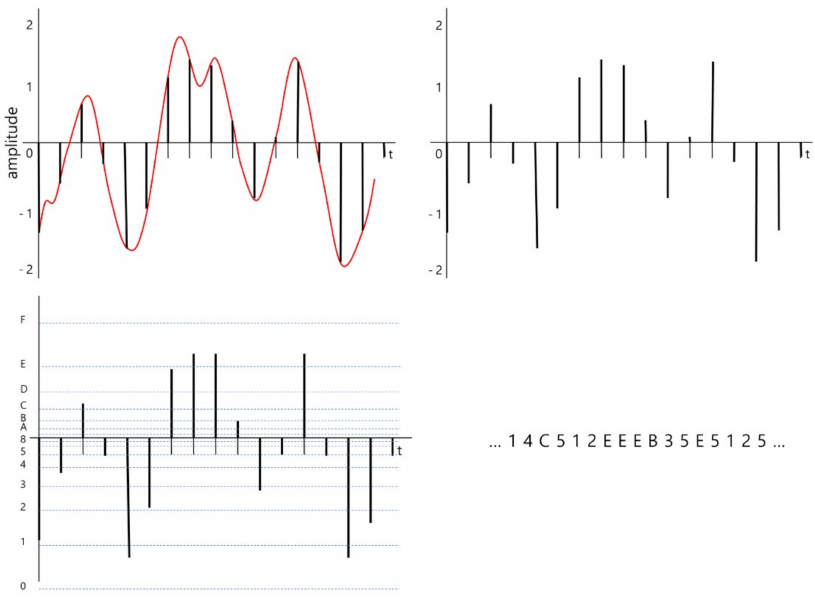
Figure 2. Process of converting an electroencephalography (EEG) bio-signal into a sequence of symbols. Sampling the original signal ( top left ), sampled signal ( top right ), quantized signal ( bottom left ), and symbolized signal ( bottom right ). baseN =